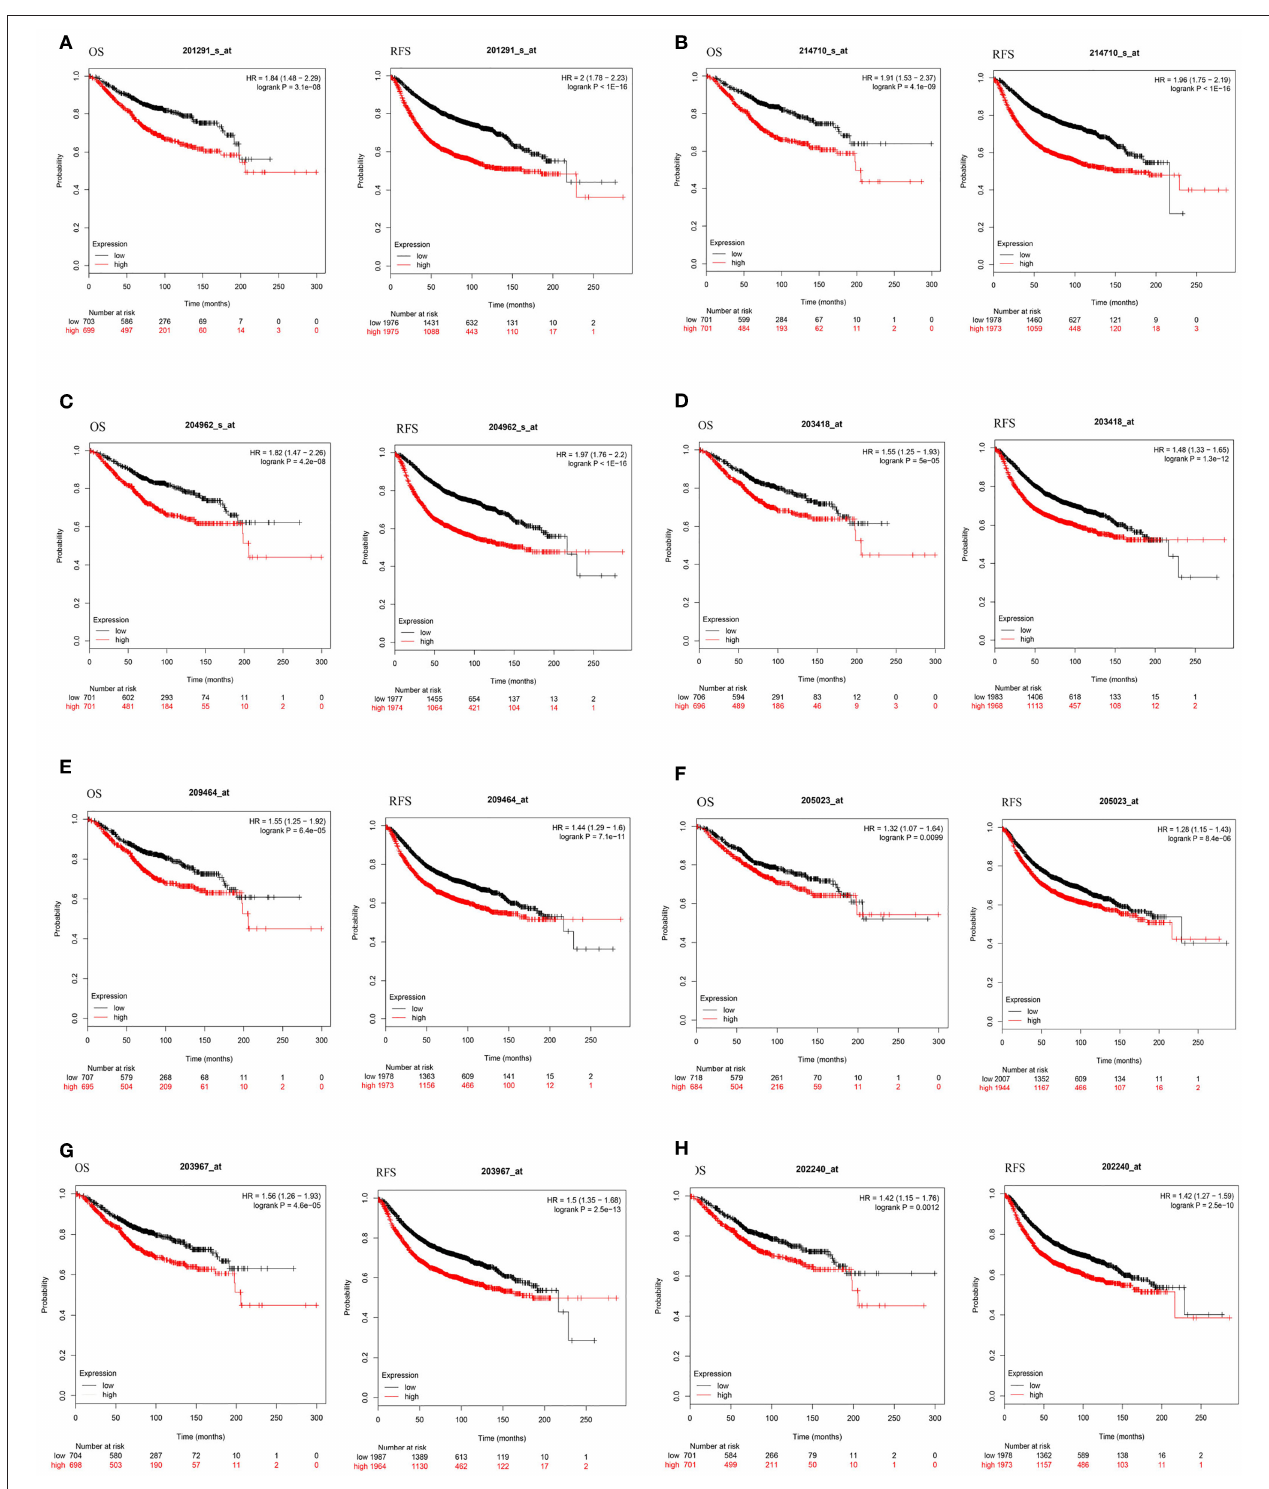
FIGURE 5 | Kaplan-Meier curves of eight prognostic DEGs in BC. Notes: The order of eight prognostic DEGs are as follows: (A) TOP2A, (B) CCNB1, (C) CENPA, (D) CCNA2, (E) AURKB, (F) RAD51, (G) CDC6, and (H) PLK1. The criterion is that when the P -value of RFS and OS were < 0.05, it is considered that DEGs are associated with the survival of